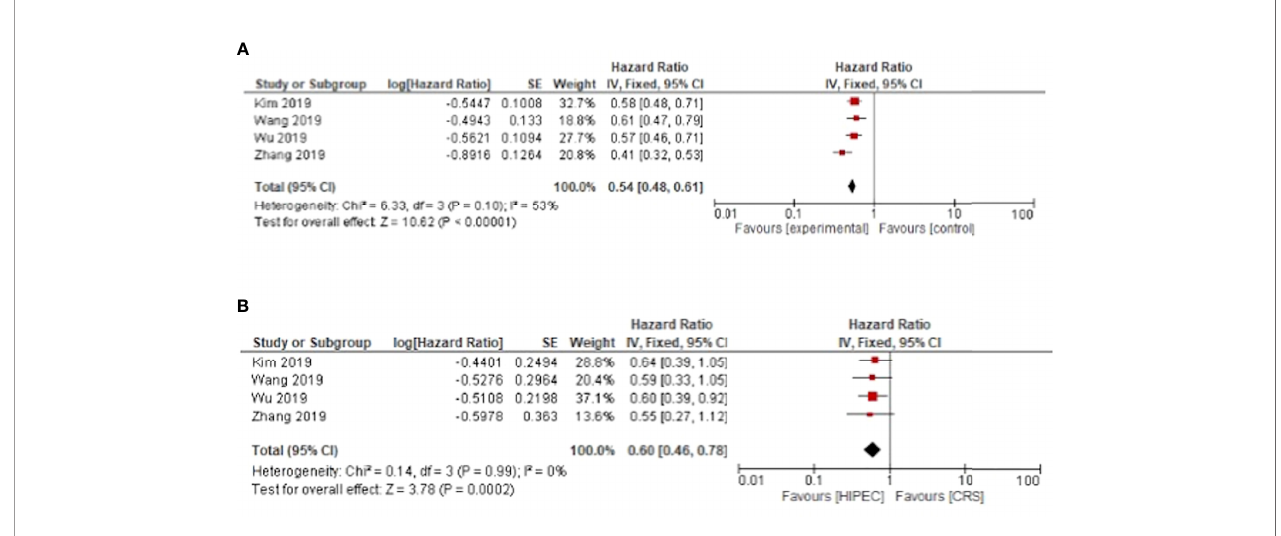
FIGURE 3 | HIPEC + CRS versus CRS disease free survival forest plots (A) primary ovarian cancer (B) recurrent ovarian